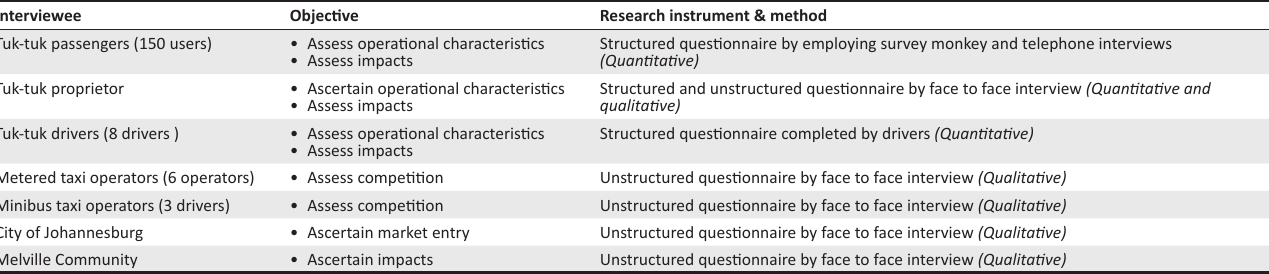
TABLE 1: Summary of data collection